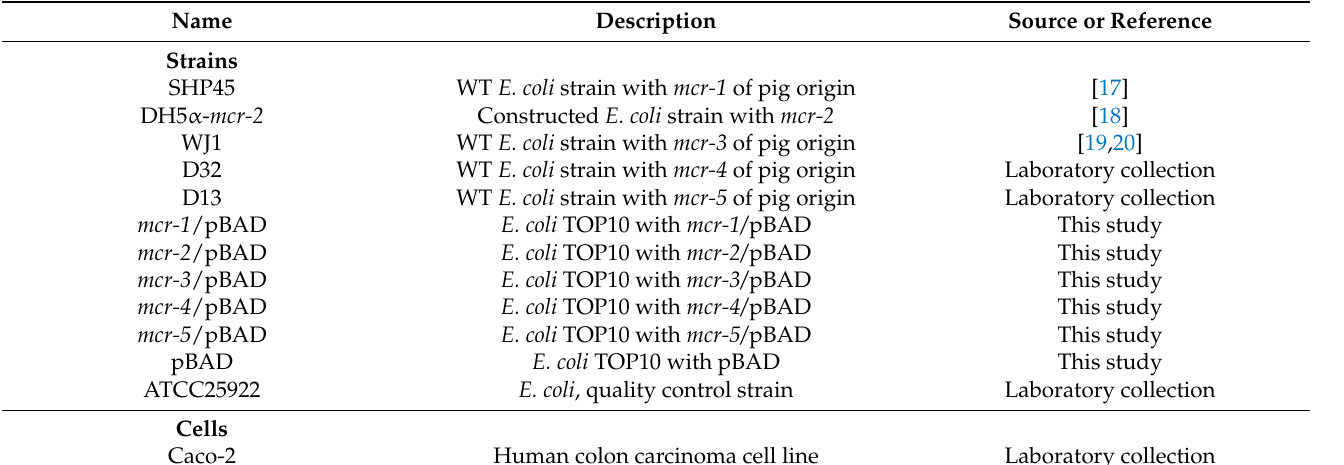
Table 1. Bacteria and cells used in this